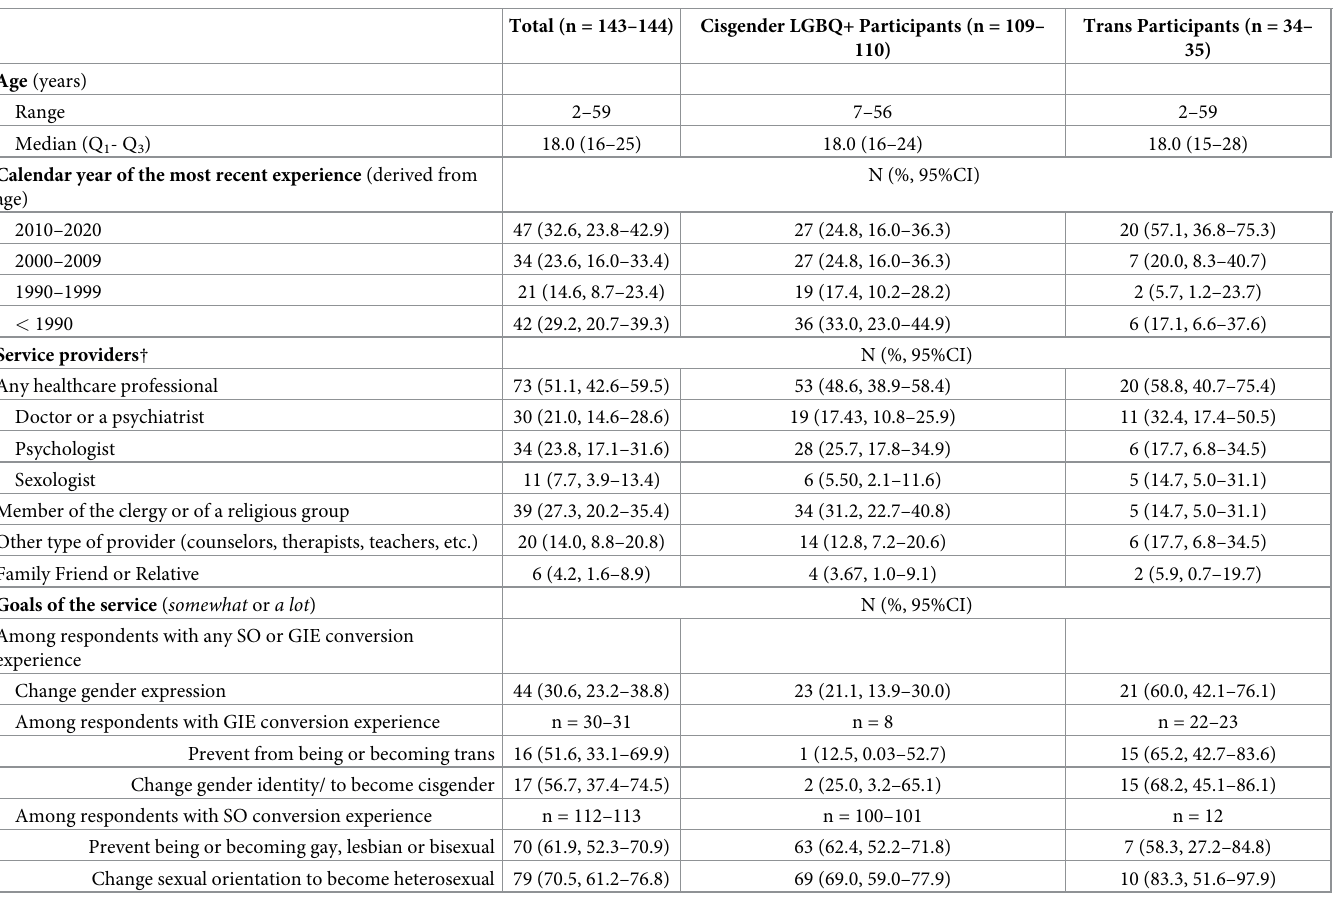
Table 7. Context of the most recent involvement in SOGIE conversion